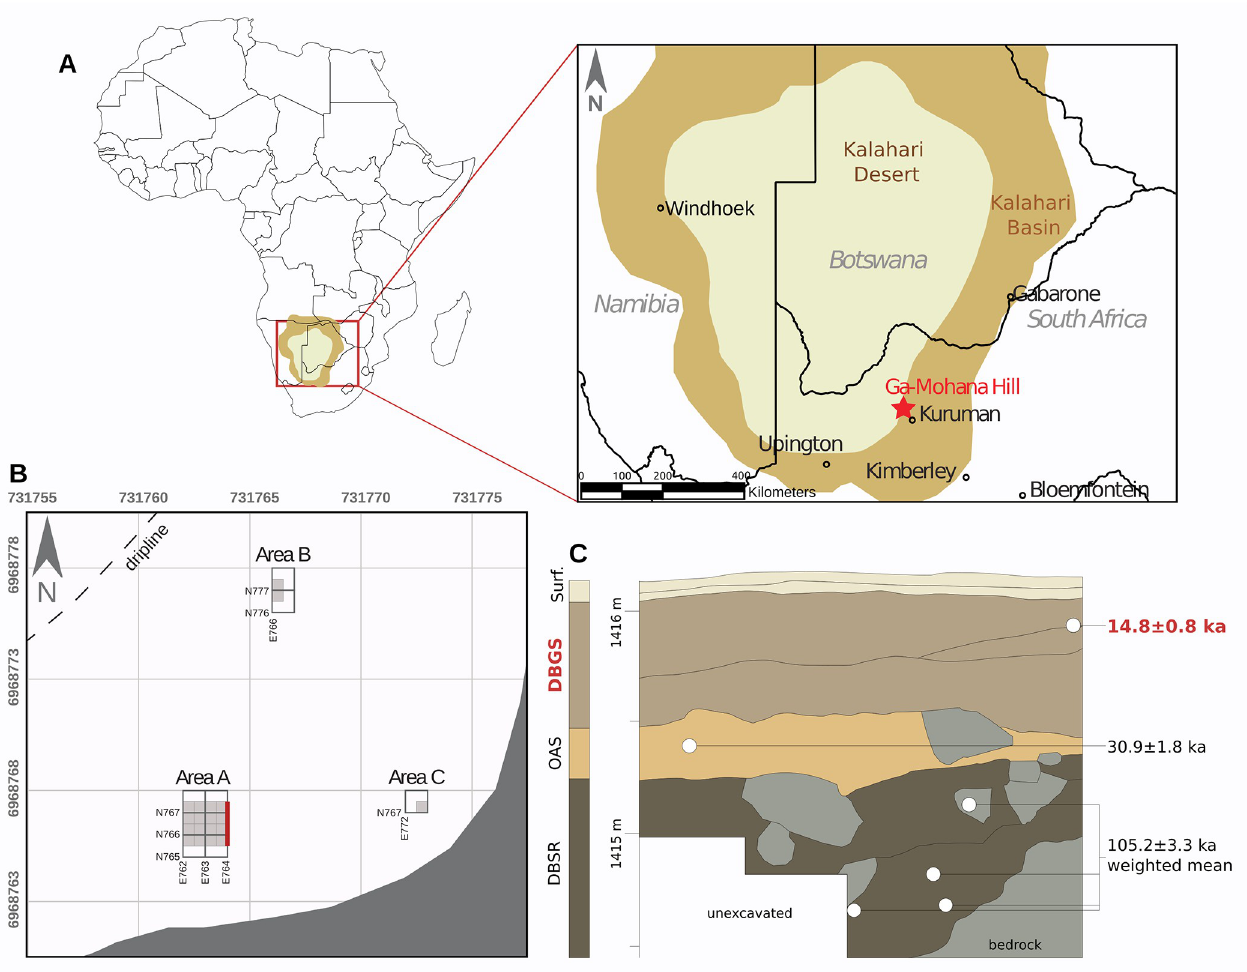
Fig 1. Map showing the study area and details of Ga-Mohana Hill North Rockshelter. A—The location of GHN relative to the boundaries of the Kalahari Desert and Basin. B–Map of GHN rockshelter with excavated areas. Red line marks profile shown in C. C -Schematic of stratigraphic boundaries, stratigraphic aggregate assignments, and optically stimulated luminescence sample locations and results. Grey-shaded areas are rock.